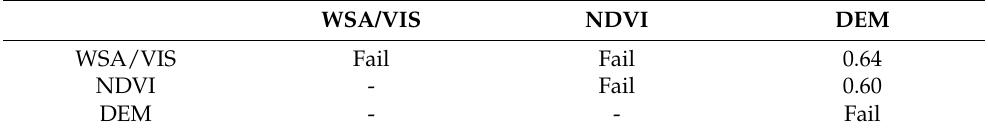
Table 3. R 2 results from combinations of two parameters for one night obtained from MOD11A1 over SFP on 10 October